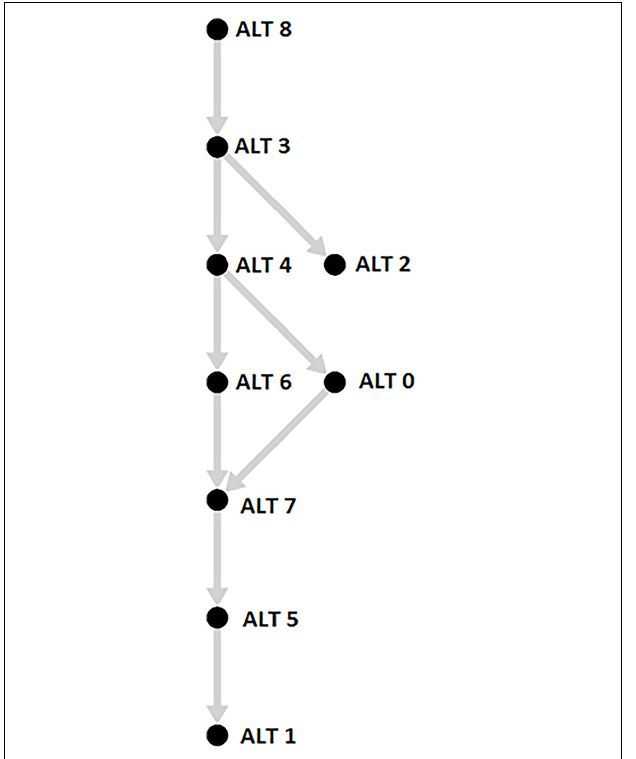
FIGURE 3 | Final pre-order of the alternatives obtained with ELECTRE III with the first scheme of weights (generated by the SuperDecisions R (cid:13) software; figure modified by the authors).